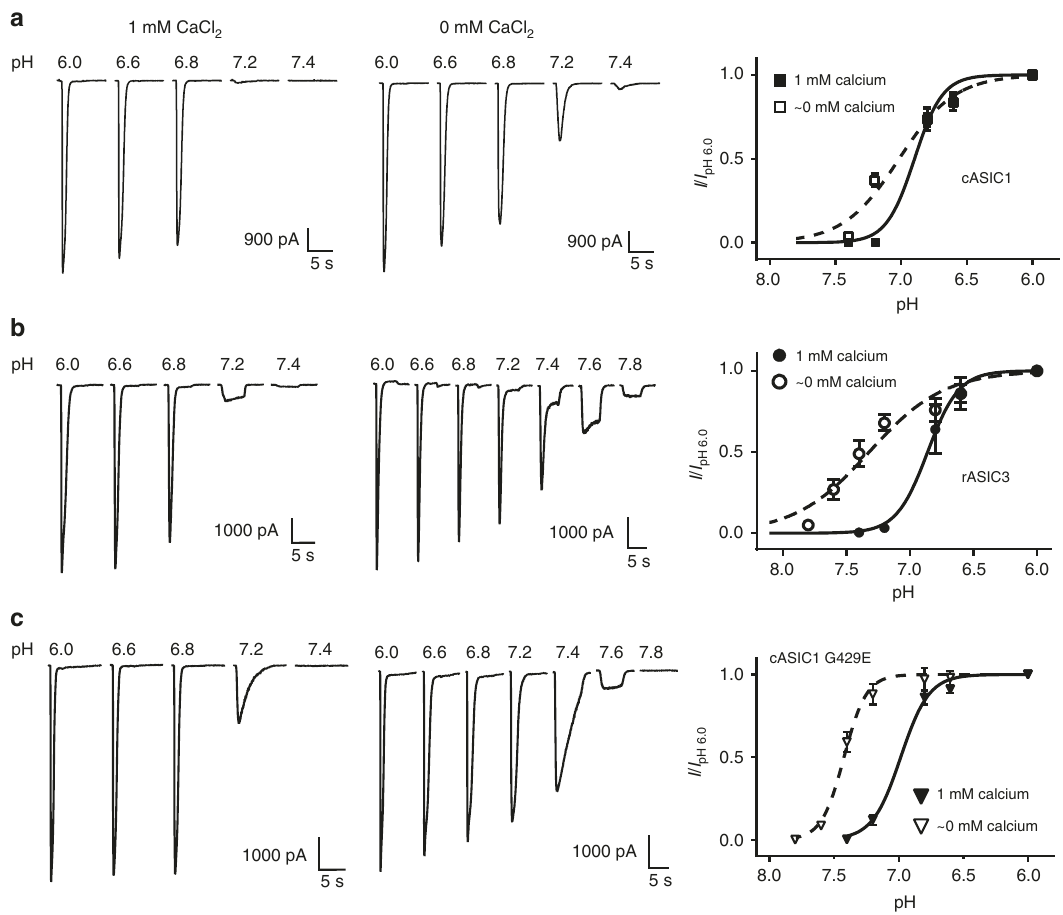
Fig. 2 A glutamate for glycine mutation in cASIC1 shifts pH sensitivity to more alkaline values. Whole-cell patch-clamp electrophysiology recordings of cASIC1, rASIC3, and cASIC1 Gly429Glu in transfected CHO-K1 cells ( V hold = − 70mV) are shown and summarized. Each expressed receptor was exposed to an acidic test solution in the presence or absence of CaCl 2 for 5s before returning to pH 8.0 external solution in the presence or absence of CaCl 2 . The summarized data show the response to low pH in the presence of Ca 2 + ( fi lled symbols) and in the absence of Ca 2 + (open symbols). a cASIC1 had a calculated pH 50 of 6.90±0.03 with a Hill value of 4.07±0.75 in the presence of Ca 2 + ( n = 5 cells). In the absence of Ca 2 + , the pH 50 was 7.01±0.03 with a Hill value of 2.05± 0.23, with both being signi fi cantly different from the control ( p <0.001, n = 5 cells). b rASIC3 had a pH 50 of 6.86±0.02 with a Hill value of 3.54±1.08 in the presence of Ca 2 + ( n = 4 cells) compared to a pH 50 of 7.32±0.04 ( p <0.001) and Hill value of 1.48±0.20 ( p <0.05) in the absence of Ca 2 + ( n = 4 cells). c The cASIC1 G429E mutant had a pH 50 of 6.98 ±0.02 ( p <0.05 compared to wild-type cASIC1) and Hill value of 3.96±0.33 in the presence of Ca 2 + ( n = 9) and pH 50 of 7.42±0.01 and Hill value of 4.99 ±0.08 in the absence of Ca 2 + ( n = 6 cells). Here, the pH 50 value was signi fi cantly different from the calcium response of the mutant ( p <0.001) and to the wild-type cASIC1 response under the same conditions ( p <0.01). Error bars are s.e.m.